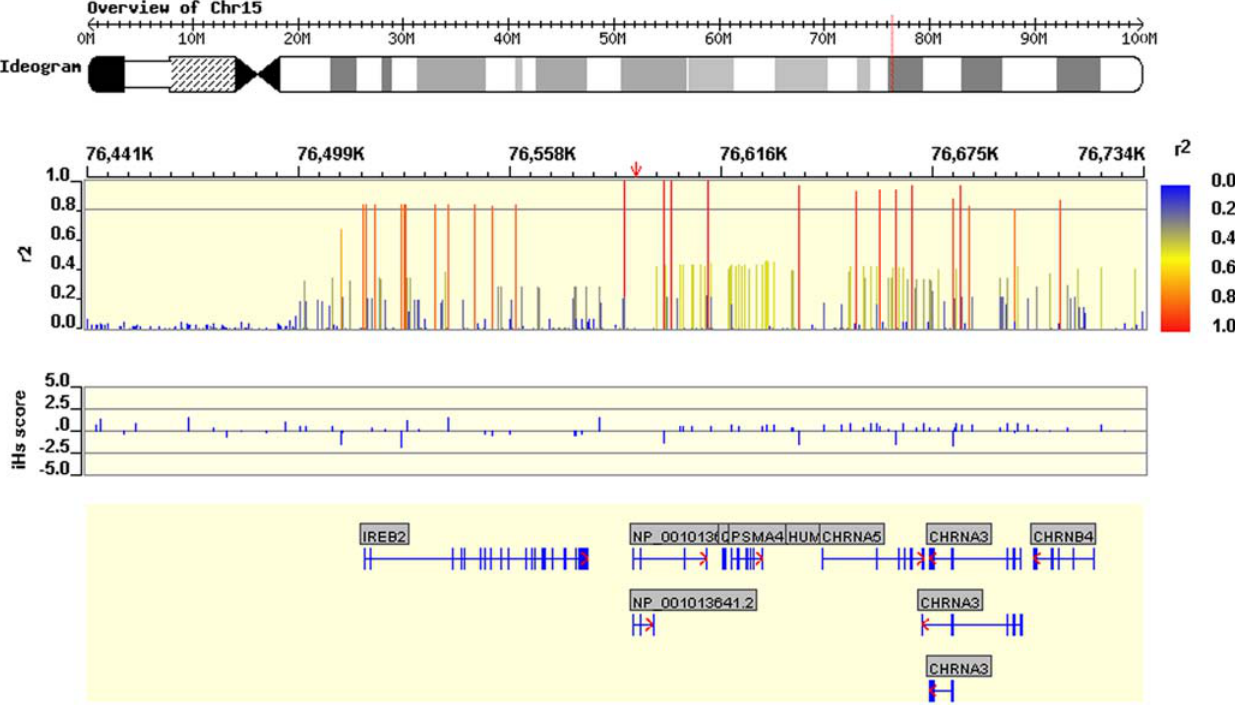
Figure 2. Region of Association around CHRNA3/CHRNA5. Annotated sections: Top: Linkage disequilibrium (r 2 ) for all HapMap SNPs with rs8034191, showing an LD extension covering CHRNA3/CHRNA5. [red] r 2 $ 0.8, [yellow] 0.5 # r2 , 0.8, [gray] 0.3 # r 2 , 0.5, [blue] 0.2 # r2 , 0.3. Middle: Recent selection score. Bottom: genic context. Exons are depicted as blue vertical lines/rectangles, while introns are depicted as blue horizontal lines. Annotations were done using the WGAViewer software [31].